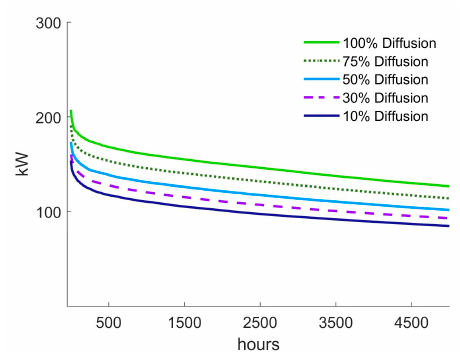
Figure 8. Duration curve applying a low charging capacity (LCC).